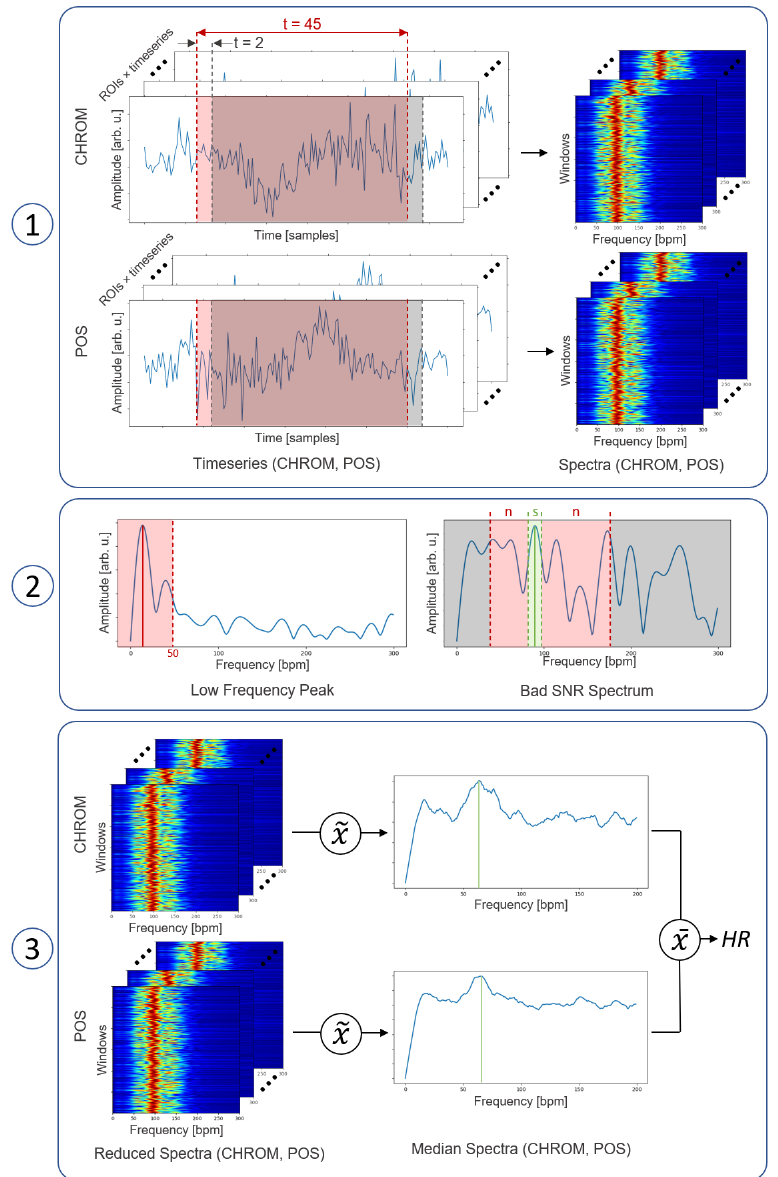
Figure 4. Overview of the HR estimation process—Windowing, time-series creation, and spectra calculation (1). Rejection of outlier spectra with low-frequency components or insufficient SNR (2). Final HR assessment by median spectra creation